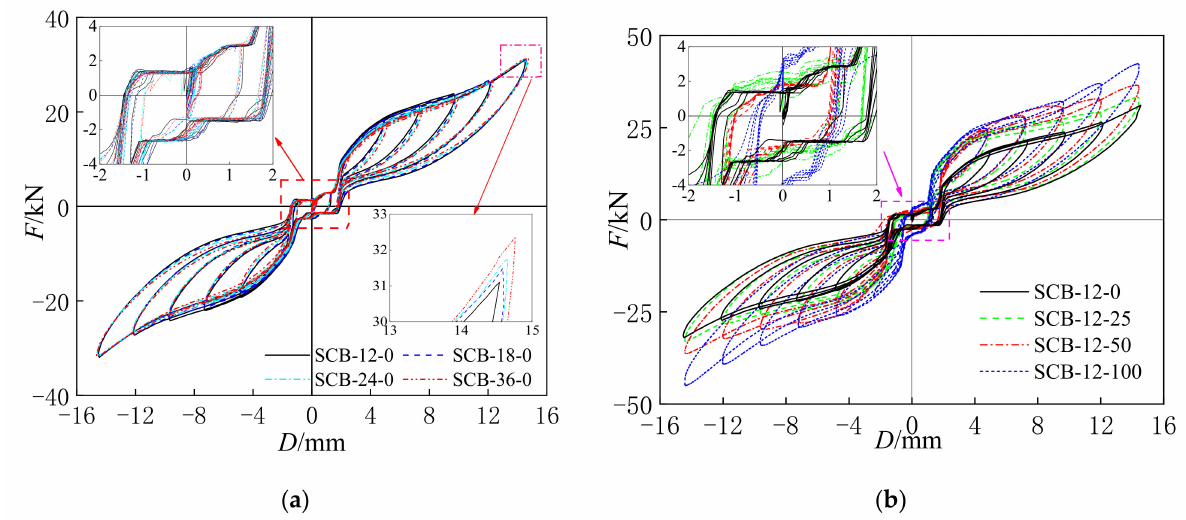
Figure 7. ( a ) Loading rate; ( b ) initial strain. Hysteresis curves of self-centering SMA brace specimens.